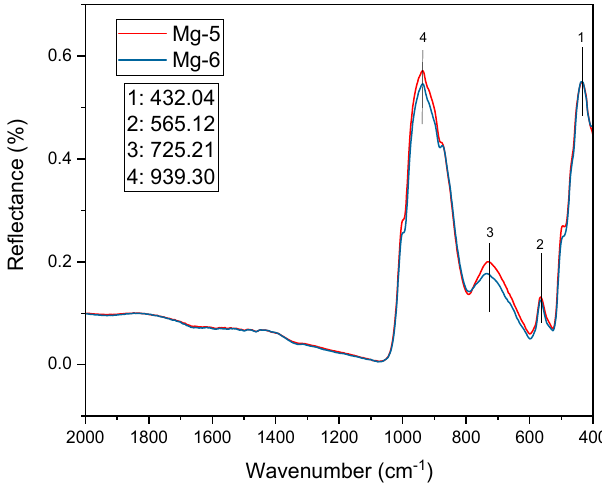
Figure 4. Fourier Transform Infrared Spectrum of MG-5 and MG-6.